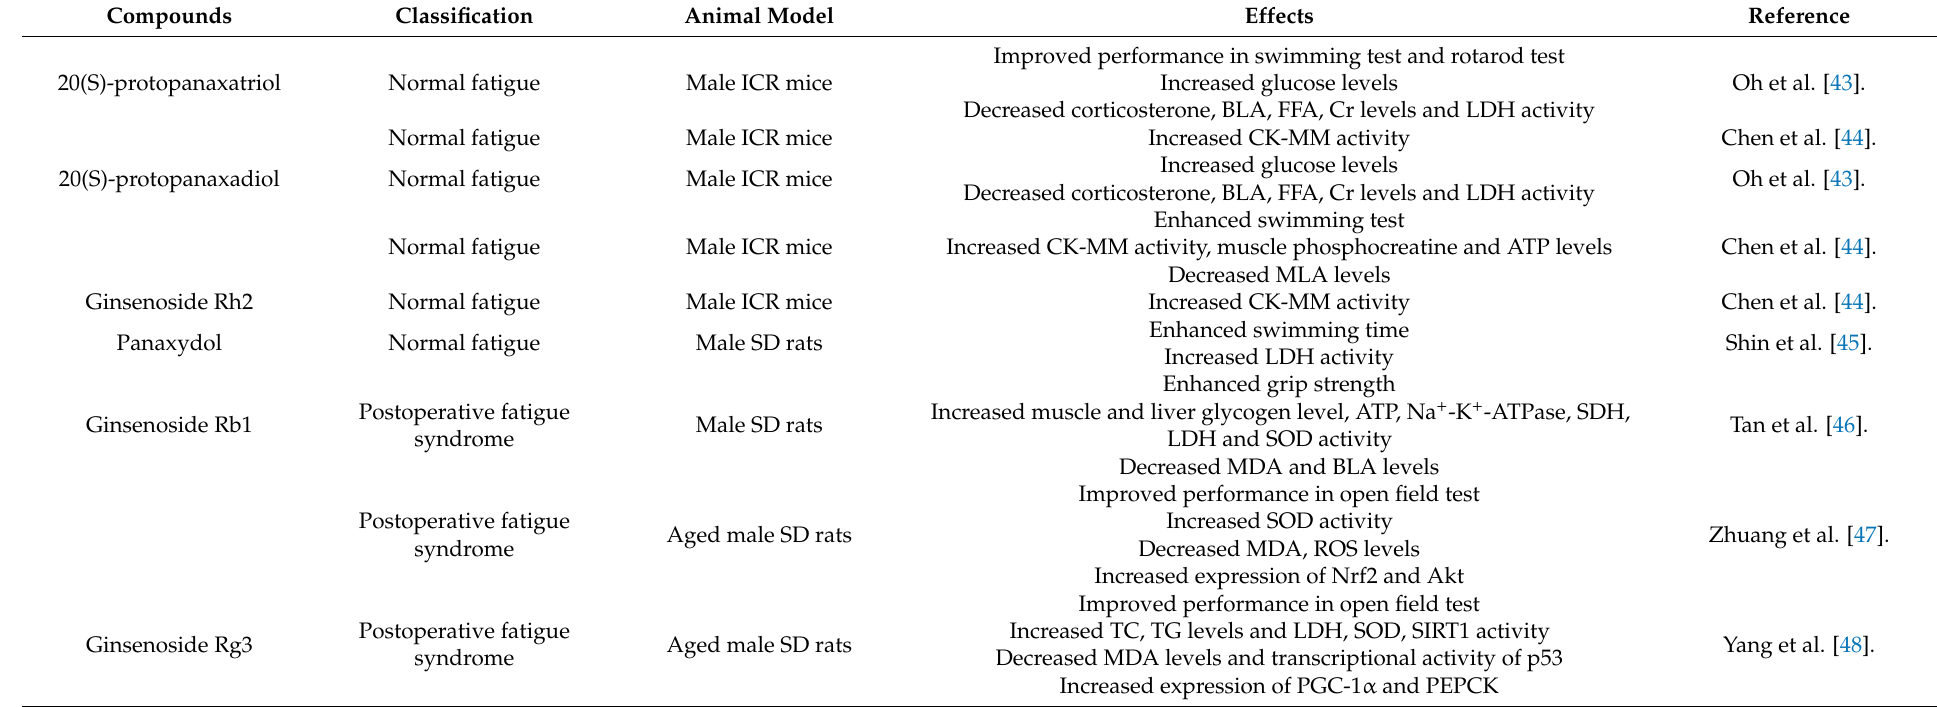
Table 2. Anti-fatigue effects of monomer compounds from P. ginseng in animal